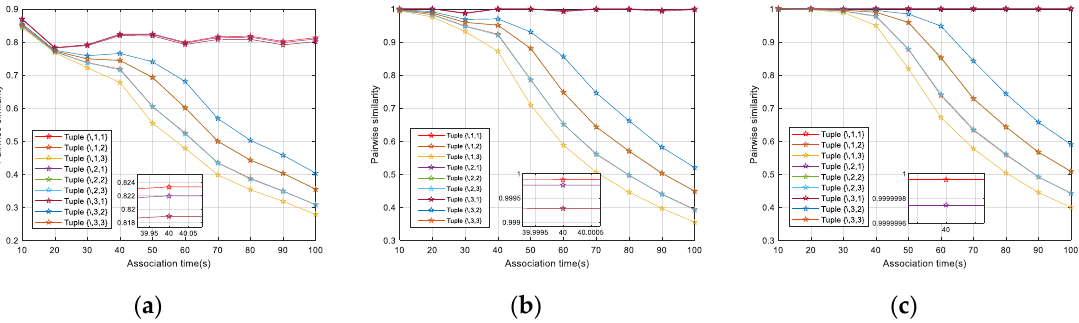
Figure 8. Similarity of stereo tracks derived from true tuples and false tuples versus di ff erent parameters τ and ε . ( a ) Similarity for τ = 1 s and ε = 2000 m; ( b ) similarity for τ = 2 s and ε = 2500 m; ( c ) similarity for τ = 3 s and ε = 3000